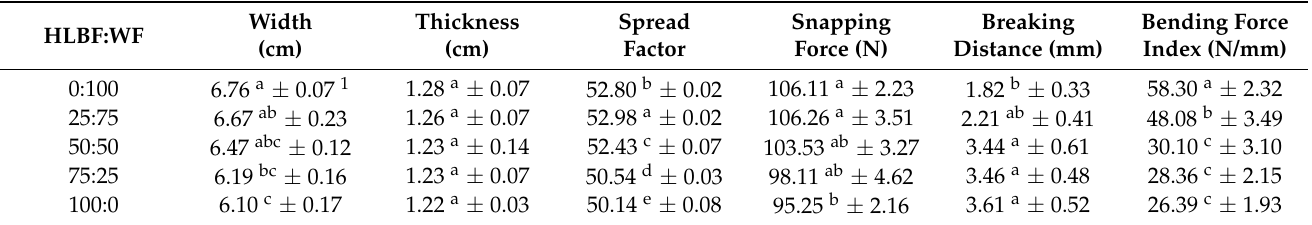
Table 2. Dimensional and textural properties of composite cookies containing wheat flour (WF) and hulless barley flour